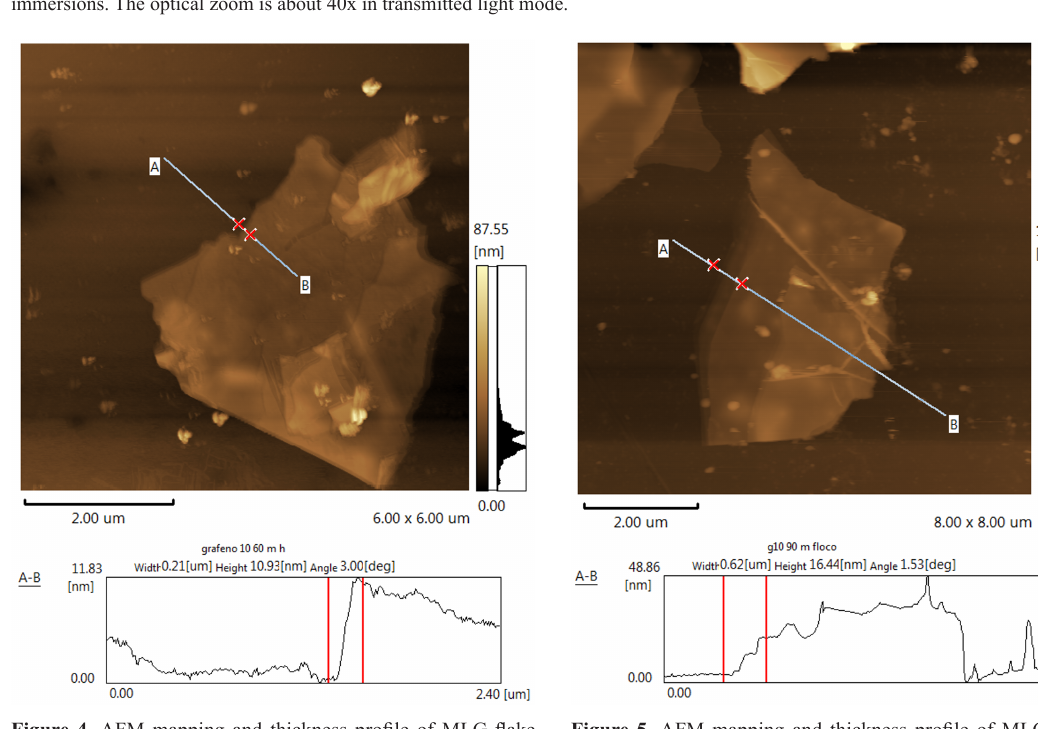
Figure 5. AFM mapping and thickness profile of MLG flake obtained with dispersion C, treated for 90 minutes in ultrasound and 10 immersions. The red crosses situated over the line A-B in micrograph represents the red lines in the surface profile (below micrograph) and were used to determine the graphene flake height.